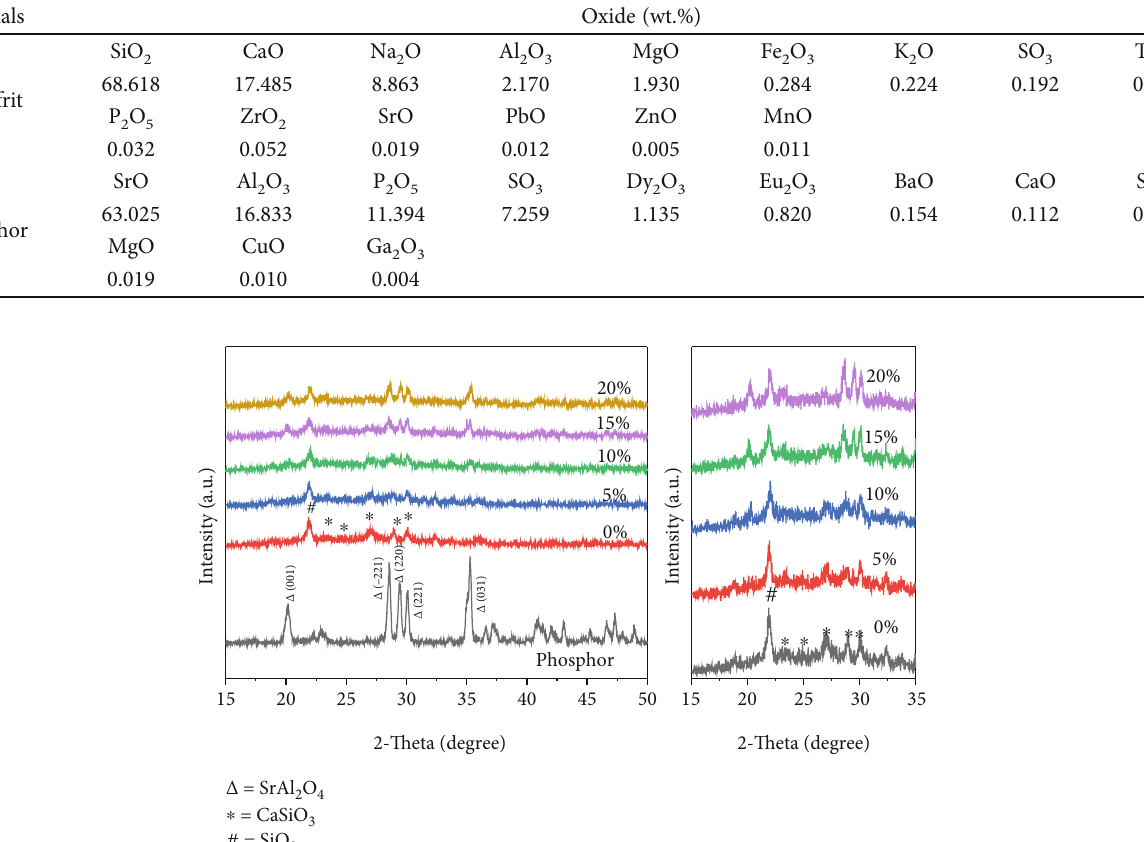
and SiO XRD peaks. 3 2